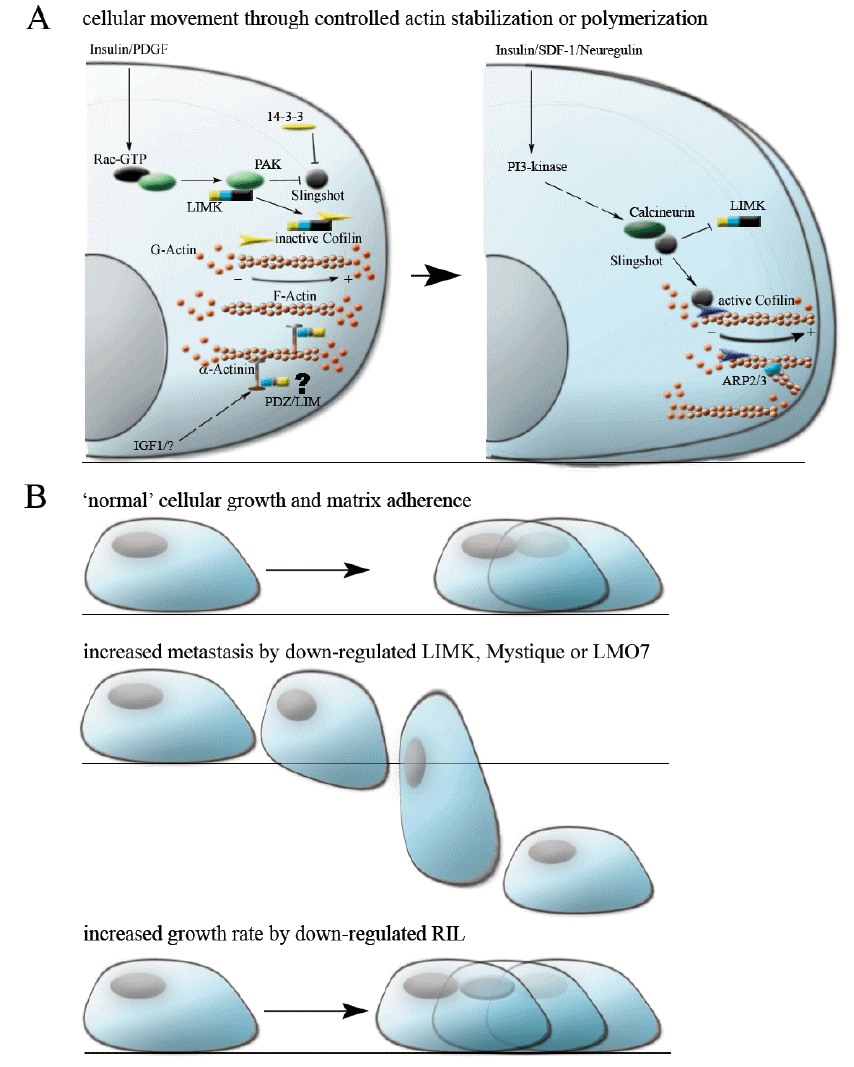
FIGURE 5. Involvement of PDZ/LIM proteins in cell motility and cancer. The PDZ/LIM protein LIMK is activated through growth factor signaling via small G-proteins (Cdc42/Rac/Rho; see also Fig. 3B) and, in turn, phosphorylates cofilin. This will render cofilin inactive and the actin cytoskeleton largely in treadmilling. When cell movements have to be initiated, however, Slingshot is activated. It will activate cofilin through dephosphorylation, thereby inducing actin destabilization at the minus ends, but an increased polymerization at the plus ends. It will also inactivate LIMK activity and is itself inhibited by both PAK and 14-3-3. Overall, the spatial and temporal regulation of cofilin activity by LIM kinase and Slingshot is critical for cell movements and directional cell migration, and the balance of these processes determines motility. How the other PDZ/LIM proteins lacking the kinase domain facilitate cell movements is not known. Although the mechanism is still elusive, it has clearly been demonstrated that Mystique and LMO7 are important in cell migration. (B) The upper panel shows the result of reduced LIMK activity in the cell. The same result has been noted for Mystique, but the mechanism is still